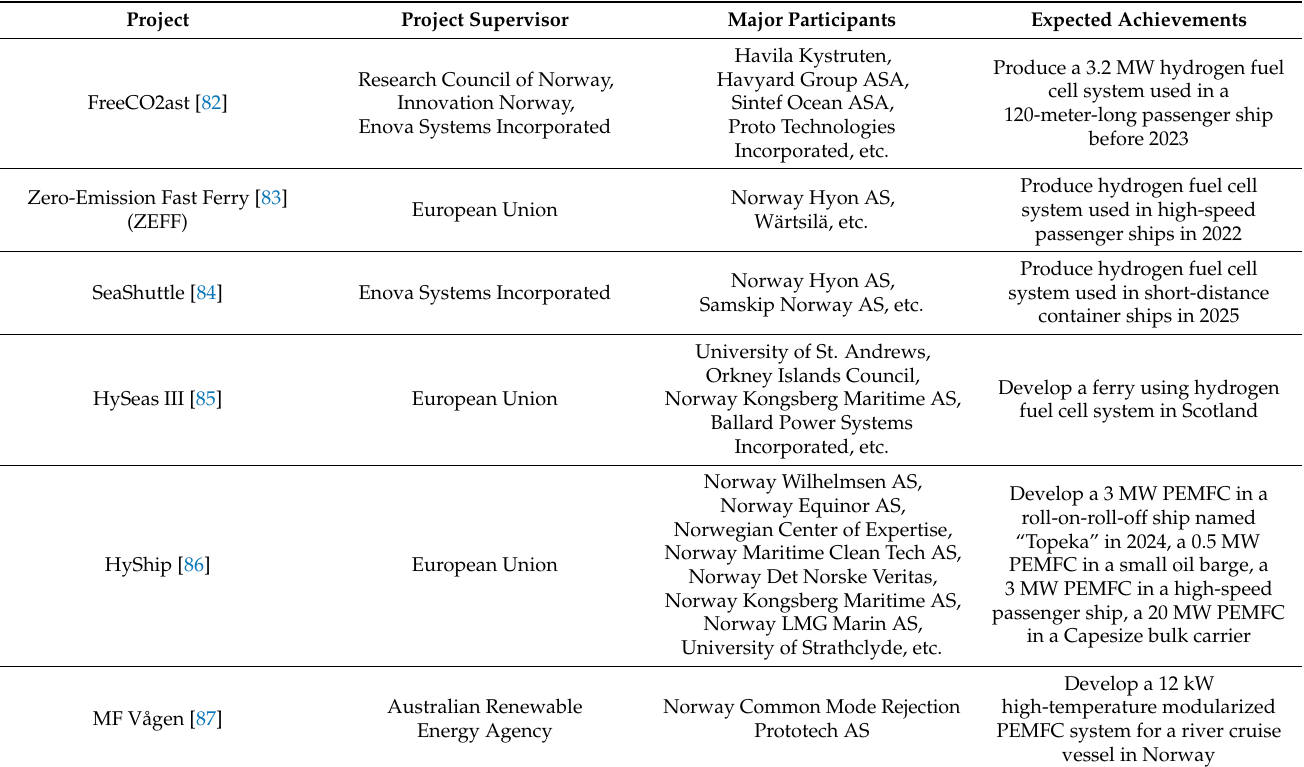
Table 2. Other representative projects involving the marine fuel cell led or participated in mainly by